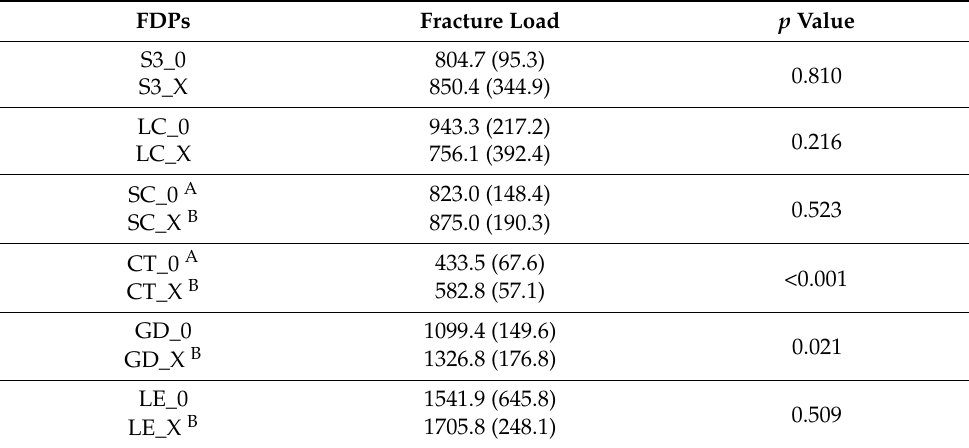
Table 4. Fracture load (N): mean values and standard deviations (SD); specimens were grouped according to their indication (directly processed—temporary: S3, LC; indirectly processed – tempo- rary: SC, CT; indirectly processed—permanent: GD, LE) and group (_0 unstressed without CS + TC (control group), _X stressed by CS + TC (experimental